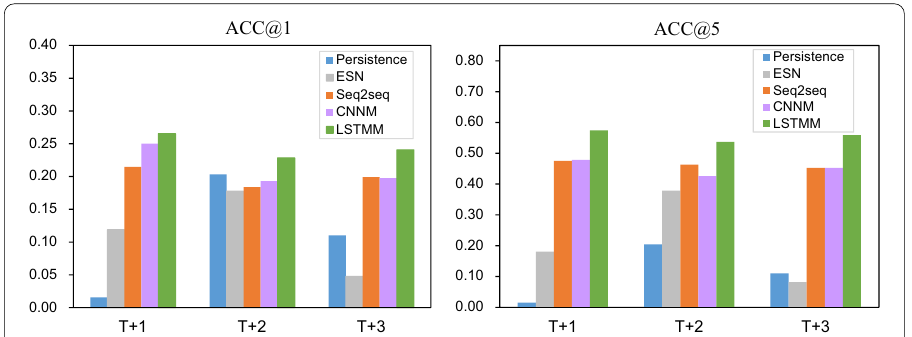
Fig. 4 Prediction accuracy comparison of trajectory prediction